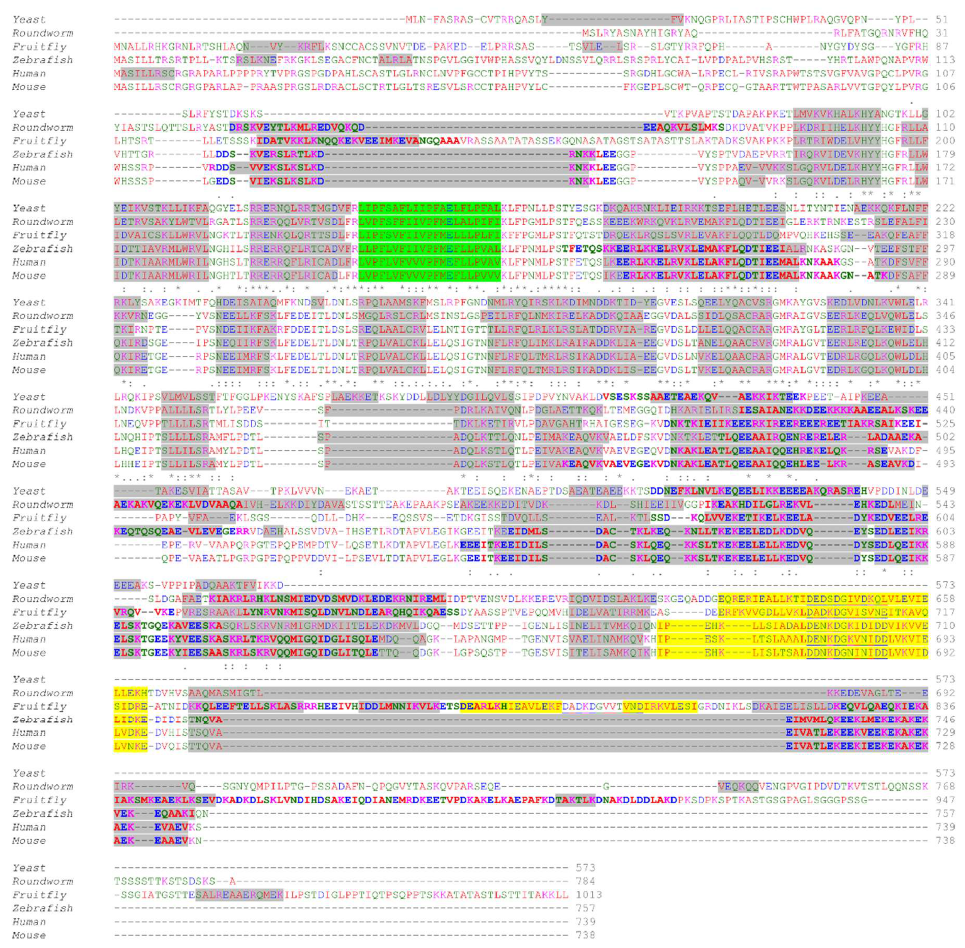
Figure 3. Primary structure alignment of LETM1 orthologs from higher and lower order organisms and predicted secondary structure and coiled-coil elements. The amino acid sequence alignment was performed using Clustal Omega [78] on LETM1 orthologs across six different species. Residue colors represent amino residue characteristics as follows: acidic (blue), basic (magenta), polar/uncharged (green) and hydrophobic (red). Residue conservation is shown below the alignment as fully conserved (*), highly conserved (:) or partially conserved (.). The locations of predicted α-helices using PSIPRED [79] are shaded grey. Green and yellow shading indicate the locations of the conserved transmembrane domains and EF-hand helices, respectively, based on the UniProt annotations. Underlining (blue) residues between the EF-hand helices indicate the location of the canonical 12 residue Ca 2+ binding loops. The prediction of the coiled-coils was performed using the Coiled-Coil Prediction server [80], using a 21 residue window, shown in bolded font. The UniProt accession numbers for the yeast, roundworm, fruitfly, zebrafish, human and mouse LETM1 proteins used in this alignment and annotation are Q08179, Q9XVM0, P91927, Q1LY46, O95202 and Q9Z2I0, respectively.